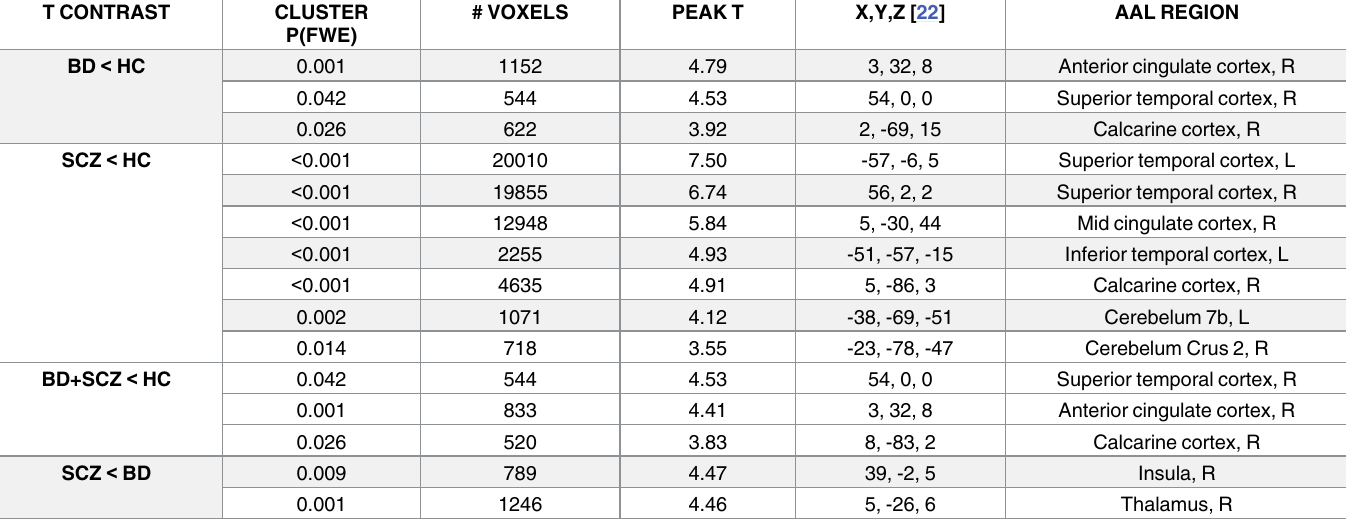
BD: bipolar disorder. SCZ: schizophrenia. HC: healthy controls. cFWE: cluster family wise error. AAL: Automated Anatomical Labeling. R: right hemisphere, L: left